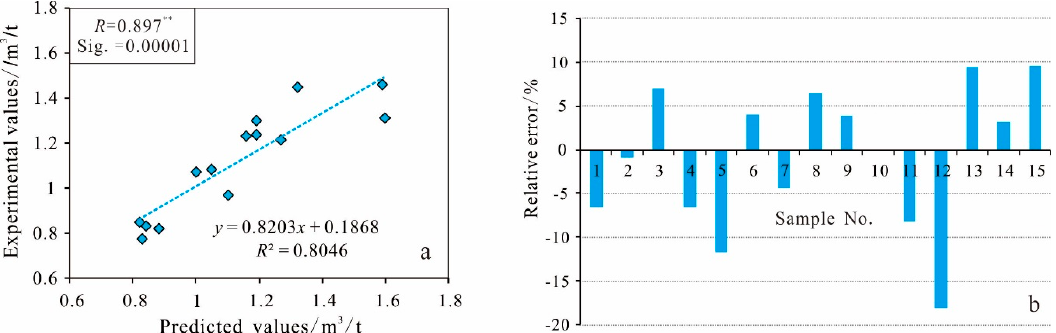
Figure 24. Reliability test of prediction model of AGC. ( a ) Correlation analysis between actual experimental values and predicted models; ( b ) error analysis of the prediction model.